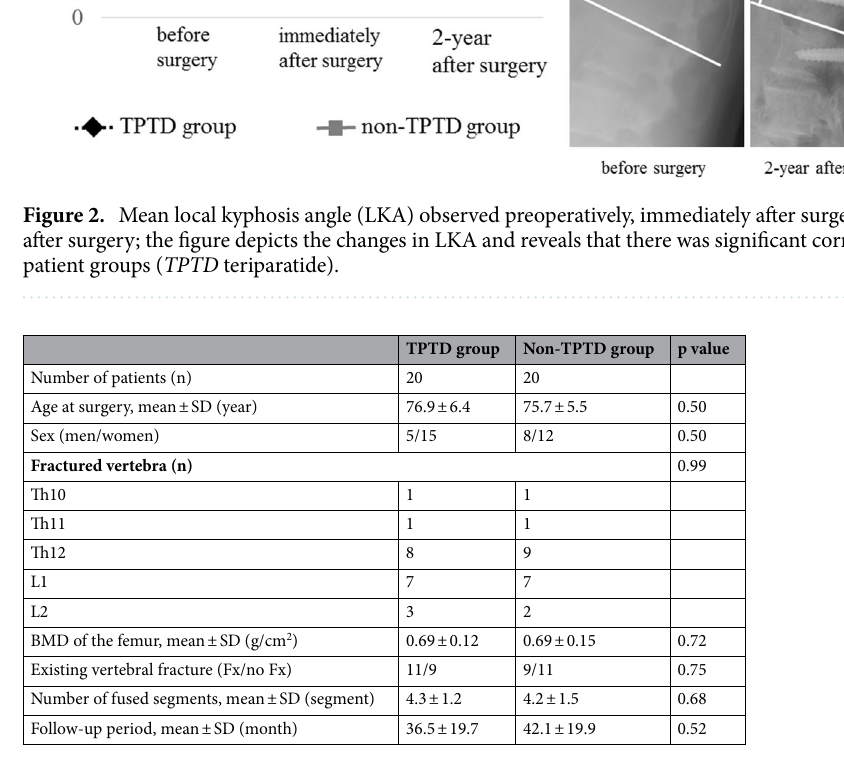
Table 3. Comparison of patient demographics after propensity score matching. SD standard deviation, BMD bone mineral density, Fx